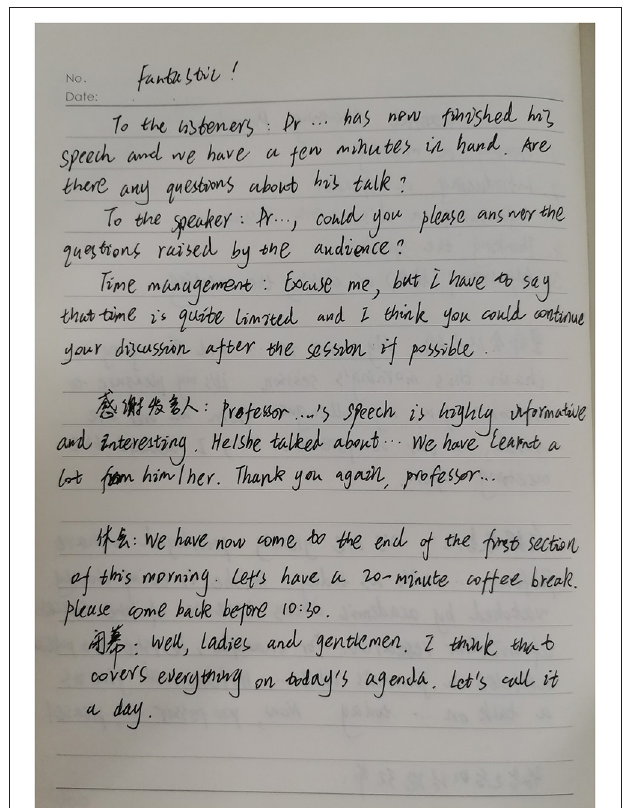
FIGURE 2 | Participant D’s class